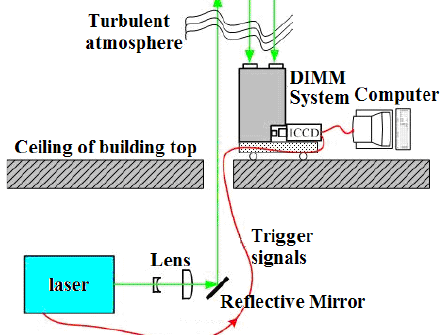
Fig. 6 Experimental configuration for remote sensing of turbulence profiles of atmosphere